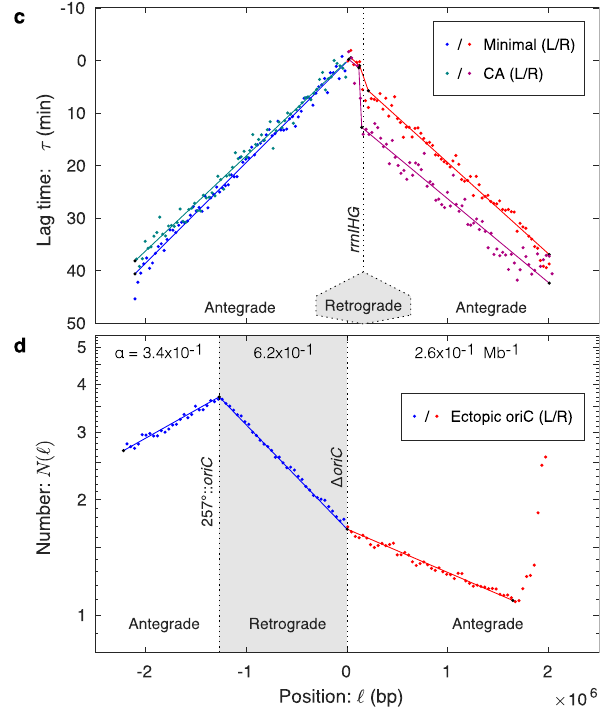
Fig. 3 | B. subtilis fork dynamics and transcriptional con fl icts. a Chromosomal structure for wild-type and mutant B. subtilis strains. The ter region in wild-type B. subtilis is positioned at172°, rather than180°, making the right arm shorter than theleft.In rrnIHG (inv),the rrnIHG locusisinvertedsothatitistranscribedinahead- onorientationwithrespecttoreplication.In257°:: oriC ,theoriginismovedto257°, resultinginashortleftarmthatterminatesattheterminusandalongrightarmthat replicates initially in the retrograde direction, before replicating the residuum of the right arm in the antegrade orientation. Data color (blue or red) represents the arm of the chromosome (R or L) and is consistent throughout the panels. Gray